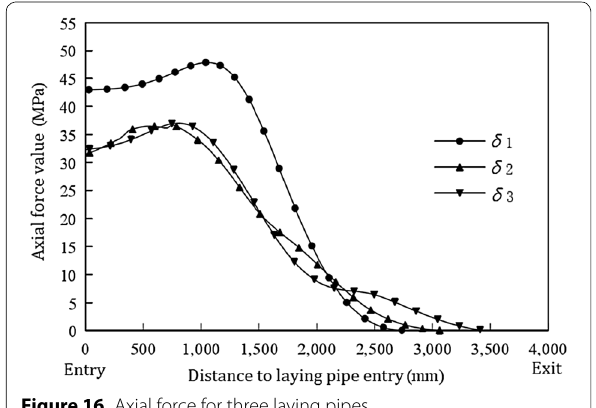
Figure 16 Axial force for three laying pipes